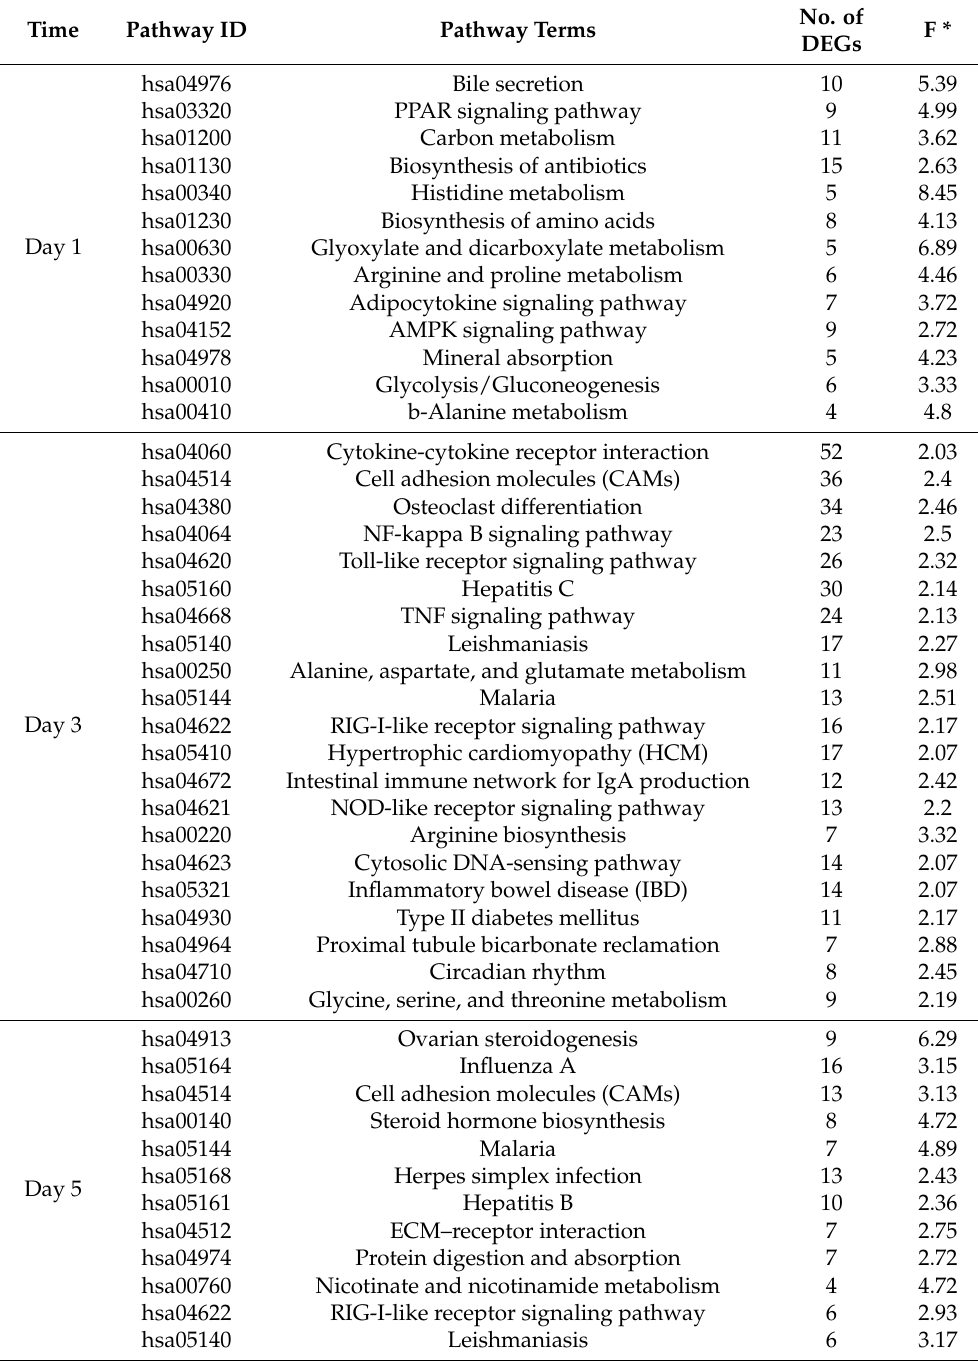
Table 5. KEGG pathways uniquely identified at each time point in IHNV-infected